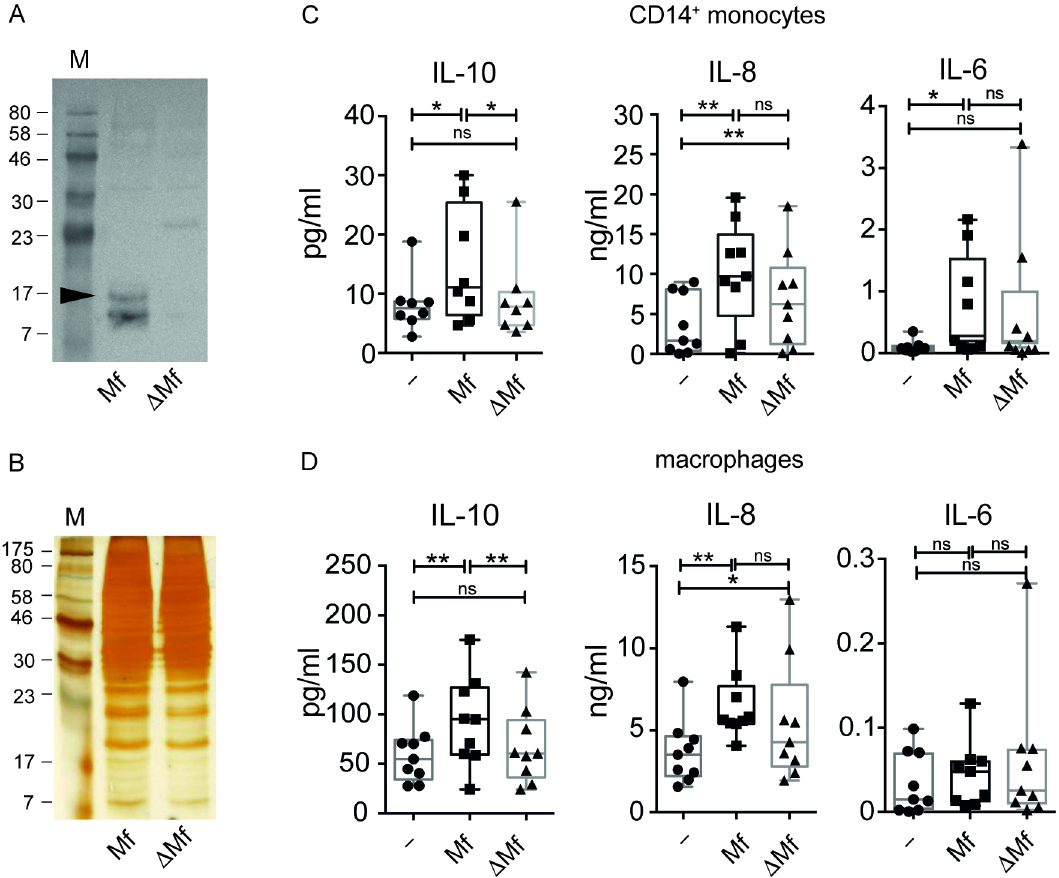
Fig 3. Brugia malayi microfilaria lysate induced IL-10 is dependent on the presenceof filarial cystatins. Western Blot (A) and Silver gel (B) showing Brugia malayi microfilaria lysate (Mf) and microfilaria lysate depleted of filarial cystatins ( Δ Mf). The black arrow indicatesBmCPI-2. C) Human monocytes, and D) monocyte-derivedmacrophages were stimulated with 20 μ g/ml of Mf or Δ Mf for 24 h. Cytokines in the supernatant were detected by ELISA. Data are from 8–9 donors and shown as mean ± SEM. Statistical analysiswas done using the Wilcoxon matched-pairs signed rank test. * p < 0.05, ** p < 0.01.